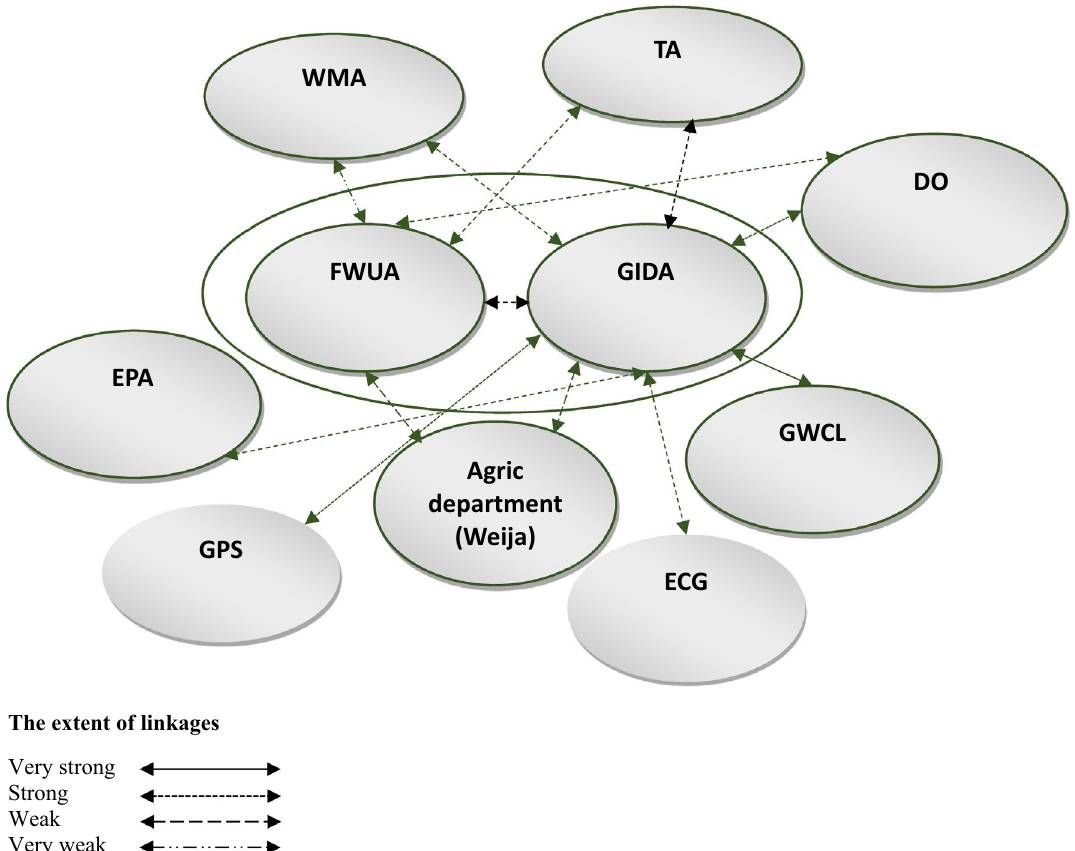
Fig. 4 Illustration of stakeholders’ extent of linkages. Source: Developed by the author, based on the results of this